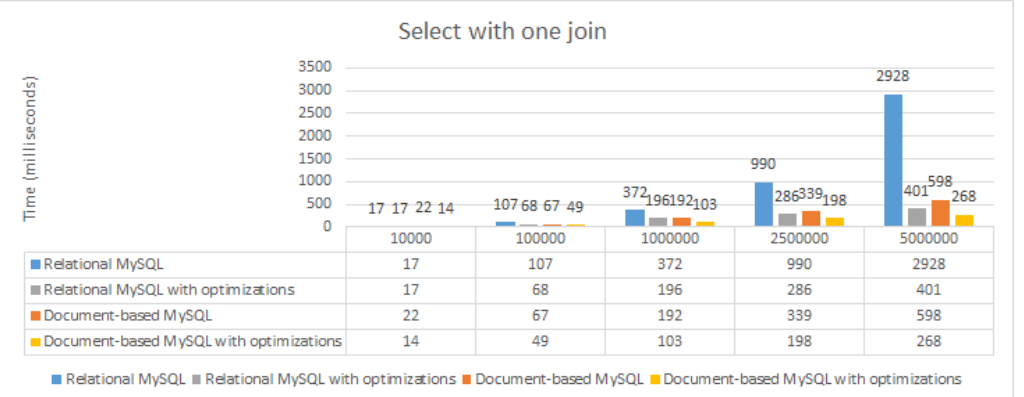
Figure 9. Performance time (ms) for the select operation with a single join.